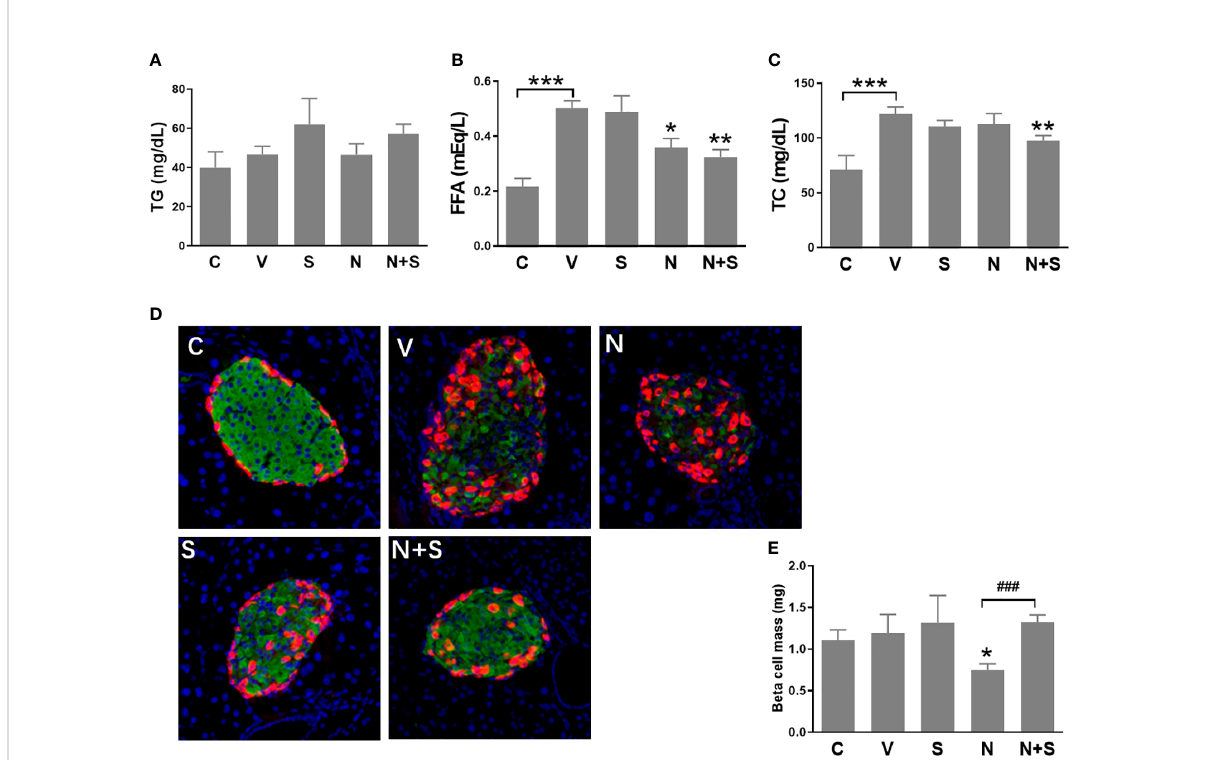
FIGURE 8 Serum lipid pro fi le and immunohistochemical analysis of the pancreas of the experimental mice. HFD mice or normal mice (C group) were treated with vehicle (V group), niacin (N group), sitagliptin (S group) or niacin plus sitagliptin (N+S group) for 6 weeks. After the experiment, collect serum for biochemical analysis and fi x pancreas for immunohistochemical analysis. (A) Triglycerides (TG), (B) free fatty acids (FFA) and (C) total cholesterol (TG). (D) Representative images of immuno fl uorescence analysis of islets stained for insulin (green), glucagon (red) and DAPI (blue). (E) Beta cell mass expressed as the percentage of insulin-positive area to total pancreas area. The results are displayed as the means ± SEM. n=5-9, *P < 0.05, **P < 0.01 and ***P < 0.001 compared to the vehicle group; ### P < 0.001 compared to the niacin